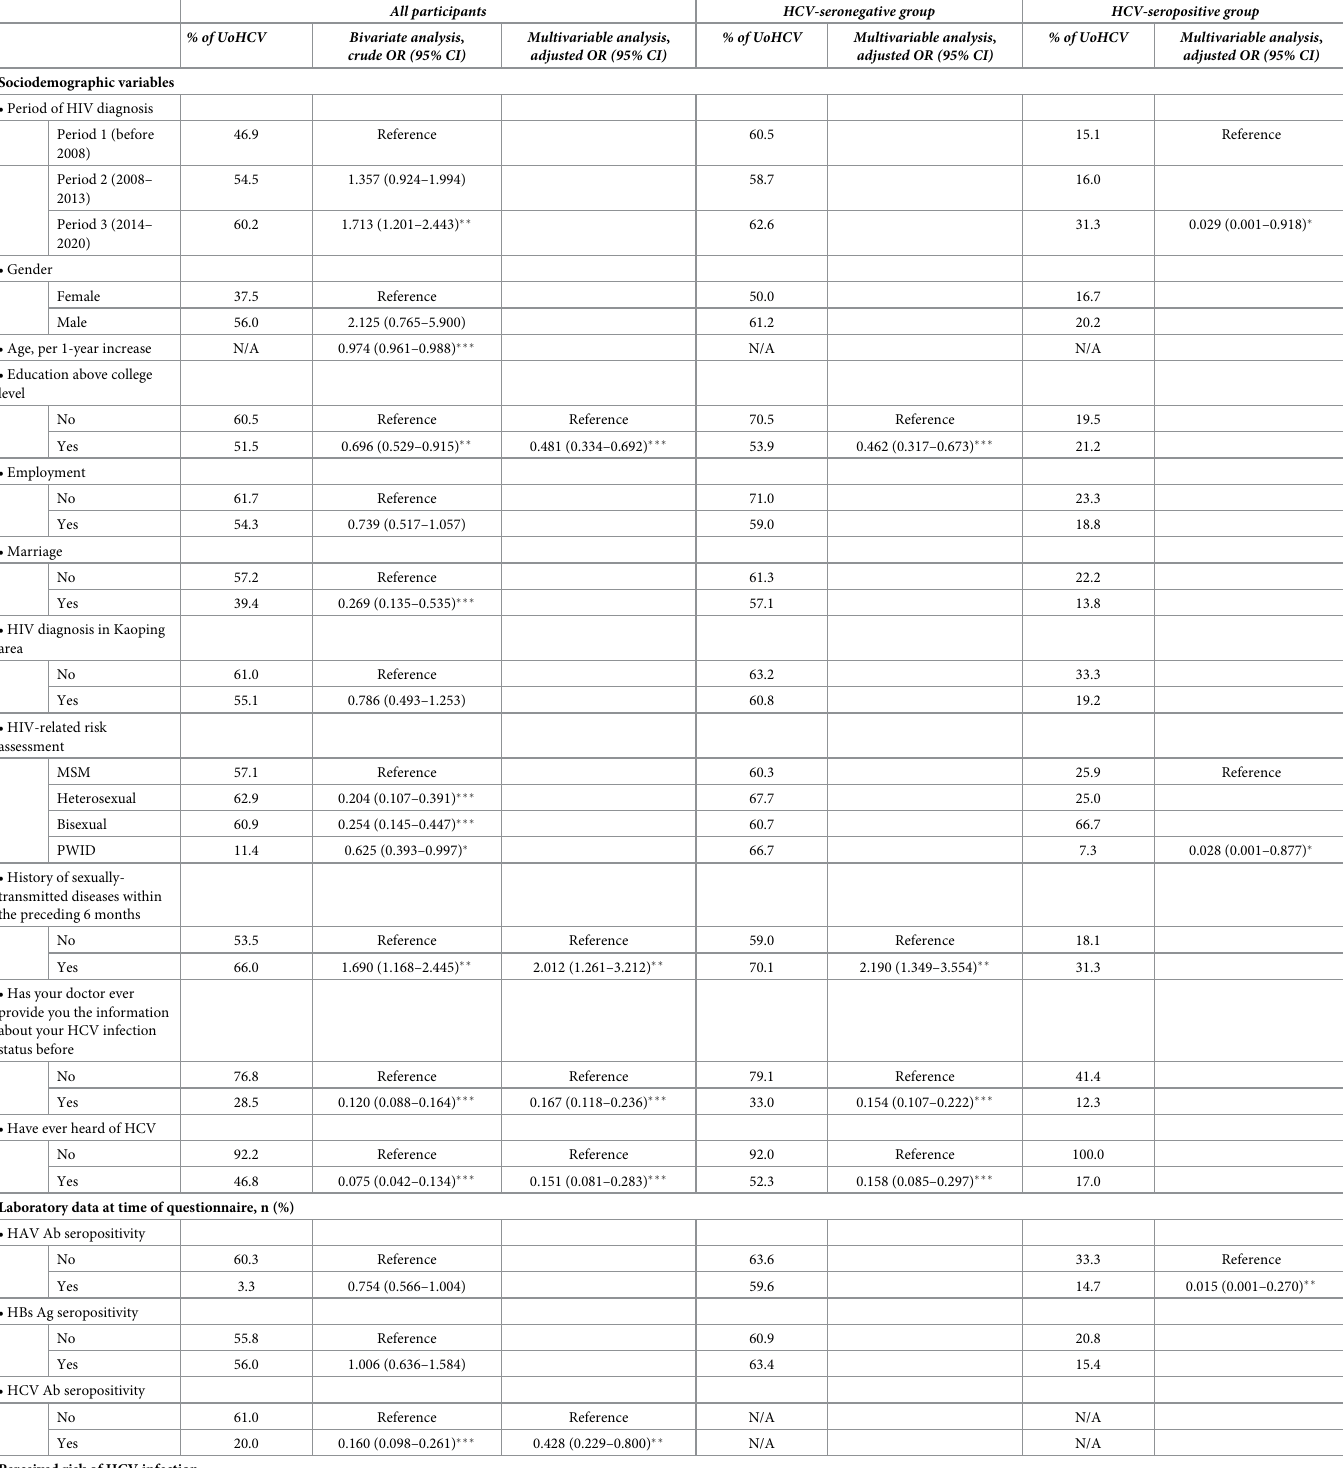
Table 2. Bivariate and multivariable analyses of factors associated with UoHCV among PLWH stratified into two groups: HCV-seronegative group (n = 734) and HCV-seropositive group (n = 110). Allparticipants HCV-seronegativegroup HCV-seropositivegroup %ofUoHCV Bivariateanalysis , Multivariableanalysis , %ofUoHCV Multivariableanalysis , %ofUoHCV Multivariableanalysis , crudeOR(95%CI) adjustedOR(95%CI) adjustedOR(95%CI) adjustedOR(95%CI)